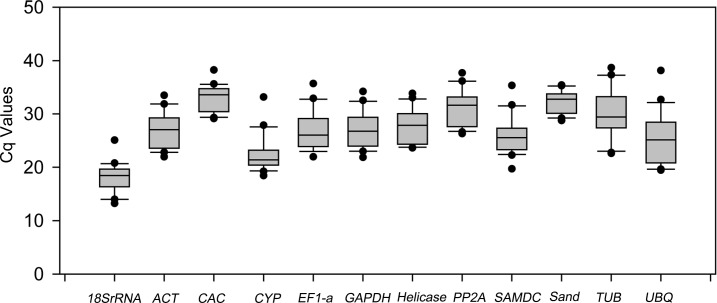
Distribution of the average Cq values of all 12 reference genes evaluated in black locust samples: 18SrRNA, ACT, CAC, CYP, EF1a, GAPDH, Helicase, PP2A, SAMDC, SAND, βTUB, and UBQ.The linear line shows median, dots for extremes, boxes for 25%-75% Cq value and whiskers for 5%-95% respectively.